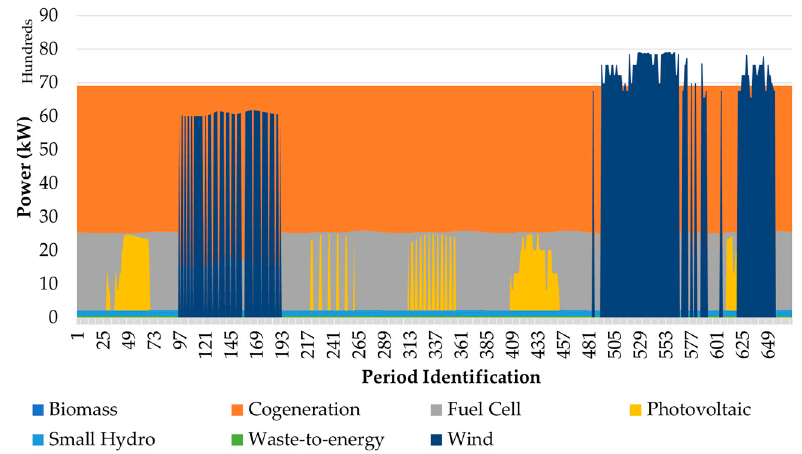
Energies 2019 , 12 , x FOR PEER REVIEW